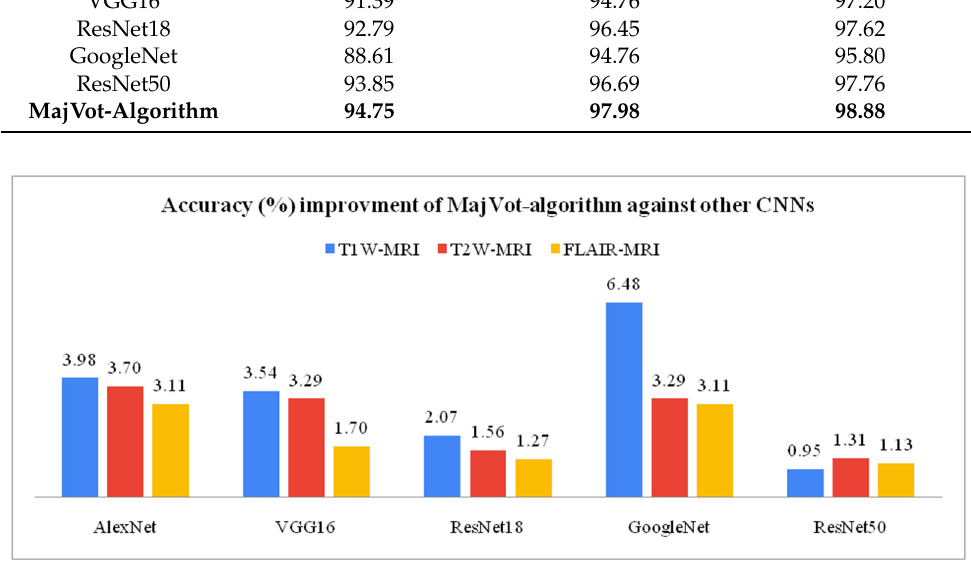
Figure 15. The accuracy improvement of the MajVot algorithm against the other five models on three datasets.